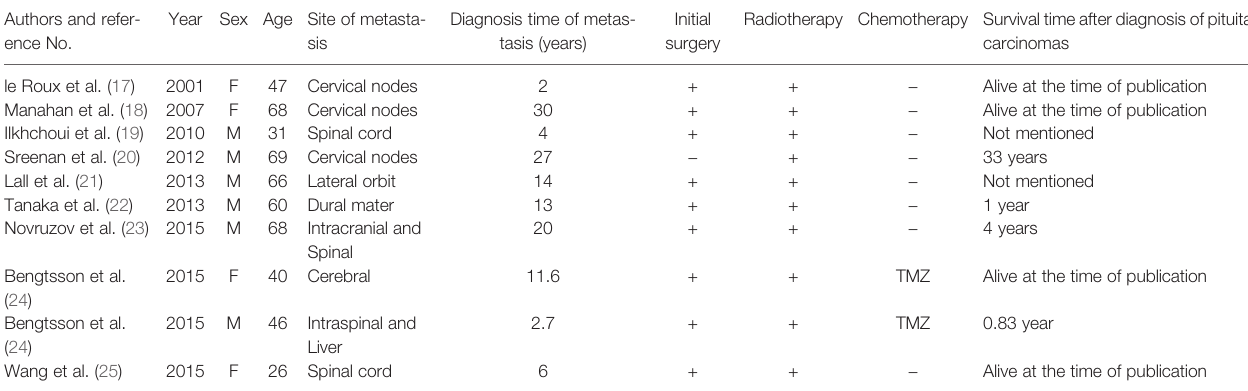
TABLE 1 | Published cases of GH-secreting pituitary carcinomas in recent 20 years. Authors and refer- ence